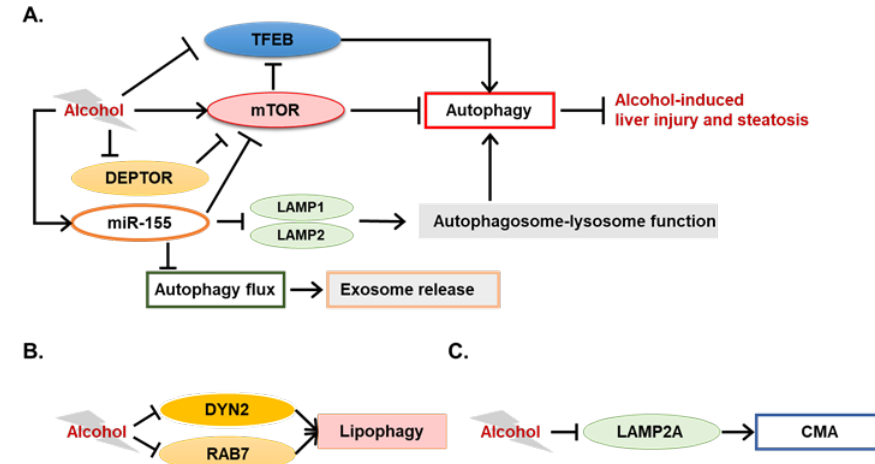
Figure 2. Novel modulators of autophagy in alcohol-related liver disease (ALD). ( A ) Alcohol can suppress transcription factor EB (TFEB) and inhibit autophagy by affecting lysosomal biogenesis. This suppression of TFEB is associated with alcohol-mediated activation of the mammalian target of rapamycin (mTOR). As a strong inhibitor of autophagy, mTOR has been shown as a central factor bridging autophagy and ALD. An mTOR inhibitor, DEP domain-containing mTOR-interacting protein (DEPTOR), is suppressed by alcohol, which is associated with the pathogenesis in ALD. Interestingly, an alcohol-induced miRNA, miR-155 , can inhibit mTOR and induce expression of genes that can initiate autophagy, while repressing the expression of lysosome-associated membrane protein ( Lamp )-1 and Lamp2 . The overall effects of miR-155 are to impair autophagy and to contribute to alcohol-induced liver steatosis, inflammation, and exosome release. What should be noted is that the discrepancy regarding mTOR activity exists among results from different laboratories, suggesting that mTOR activity may be varied by factors other than alcohol use. ( B ) Alcohol-treatment can decrease Dynamin2 (DYN2) and RAB7 expression in rat livers, both of which are critical to lipophagy. ( C ) Alcohol can suppress LAMP2A expression, which is a key factor during the process of chaperone-mediated autophagy (CMA).